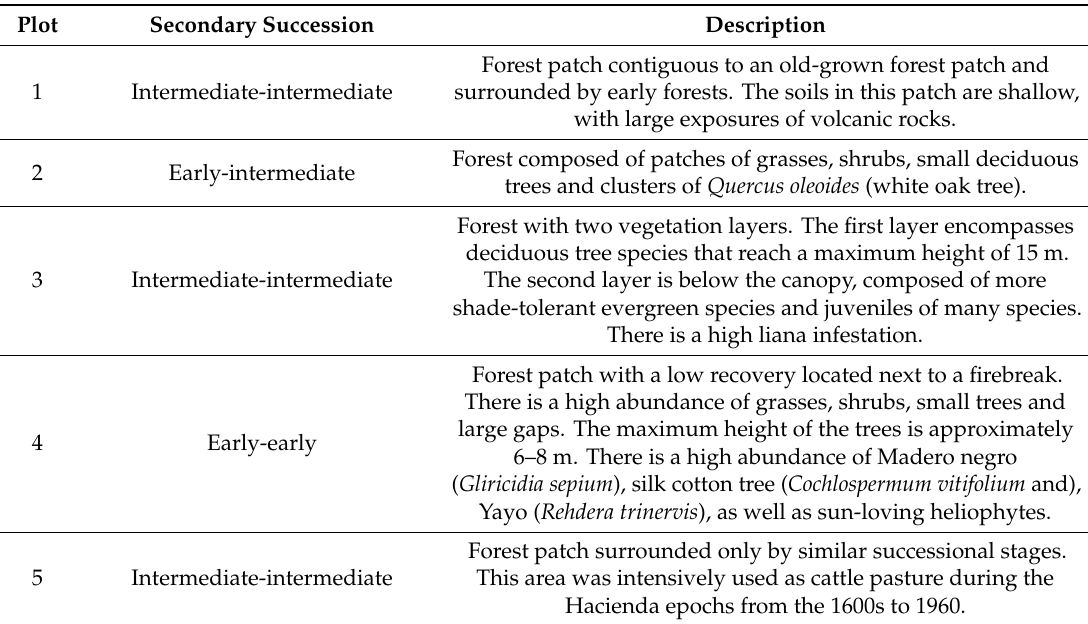
Table 1. Description of the five forest plots surveyed on the estimation of dead woody components at the Santa Rosa National Park Environmental Monitoring Super Site, Costa